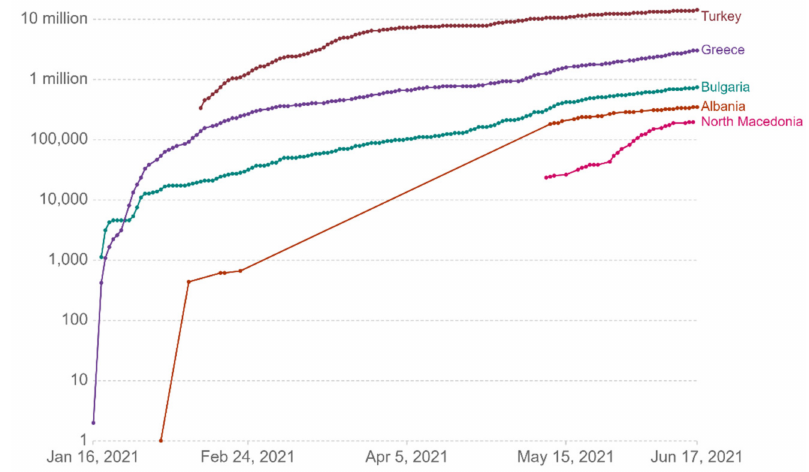
Figure 12. People fully vaccinated.